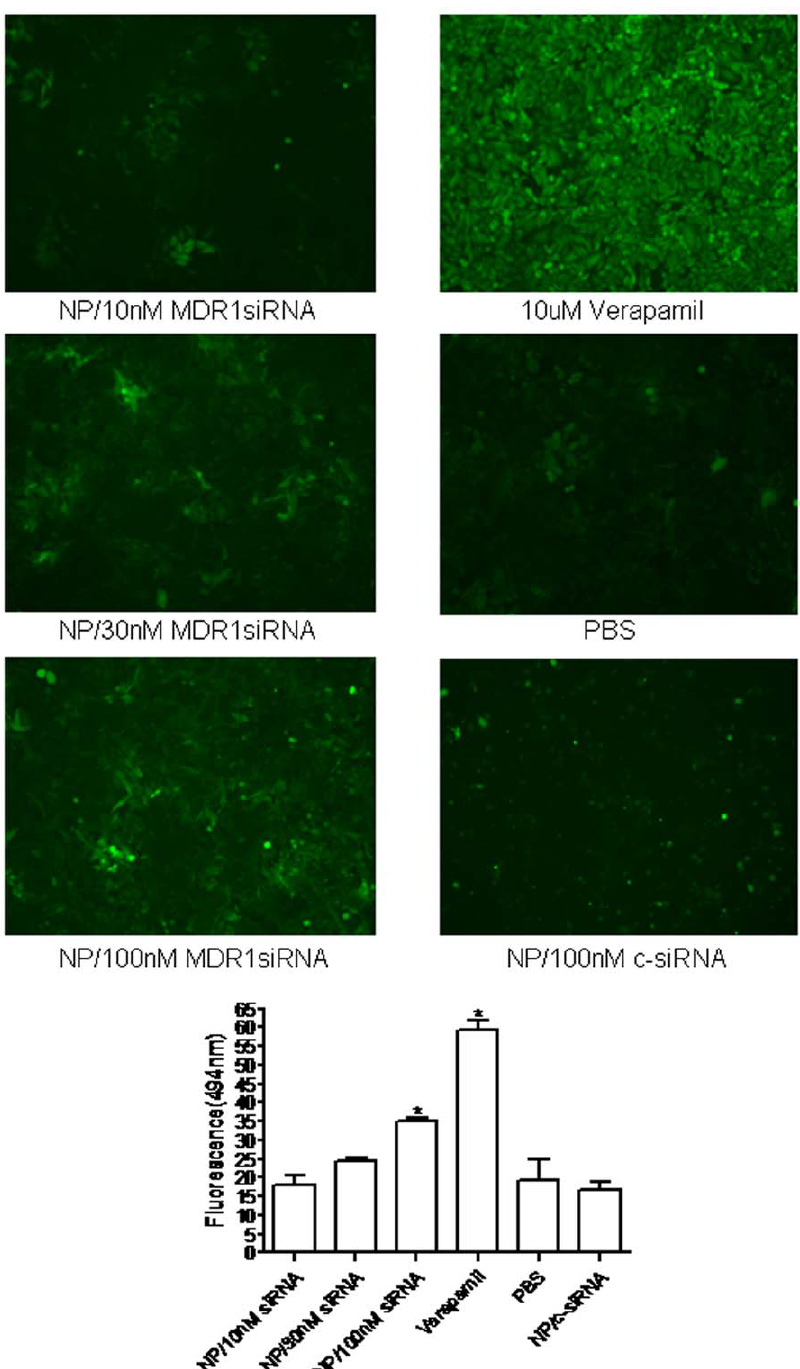
Figure 5. Effect of MDR1 siRNA loaded nanoparticle on P-gp – mediated uptake and efflux was analyzed using calcein AM. Cells treated with MDR1 siRNA were shown to decrease calcein AM efflux in a dose-dependent manner as determined by image analysis, and this was confirmed by microplate spectrofluorometer analysis. P values are shown as follows: * P , 0.05.